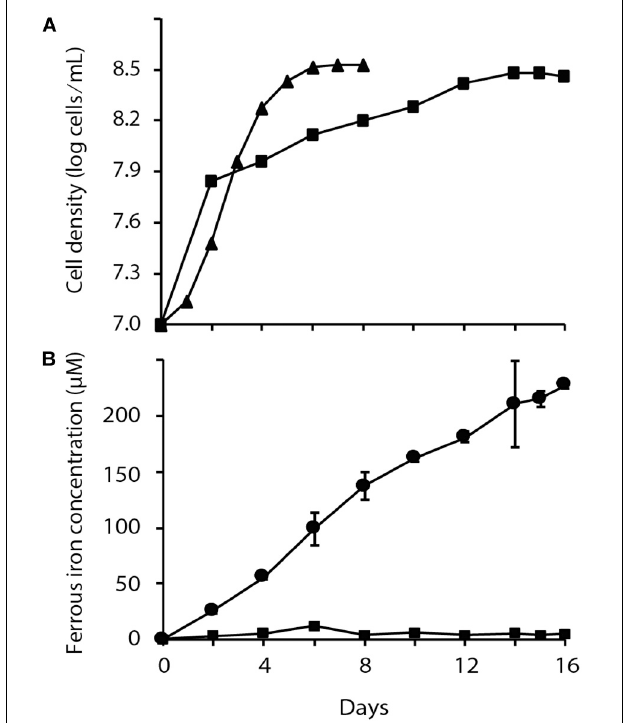
FIGURE 1 | Chemolithoautotrophic growth of Acidithiobacillus ferrooxidans via aerobic and anaerobic respiration with S 0 as the electron donor. (A) Time dependent changes in cell density of aerobically ( (cid:78) ) and anaerobically ( (cid:4) ) respiring cultures and (B) Fe 2 + formation in aerobic ( (cid:4) ) and anaerobic